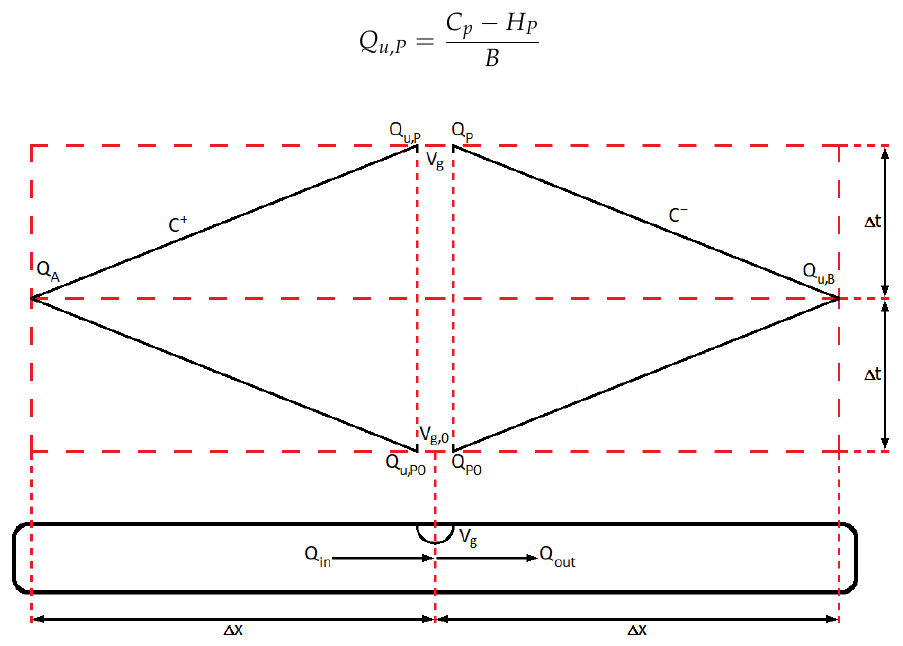
Figure 3. Grid for two phase Method of Characteristics